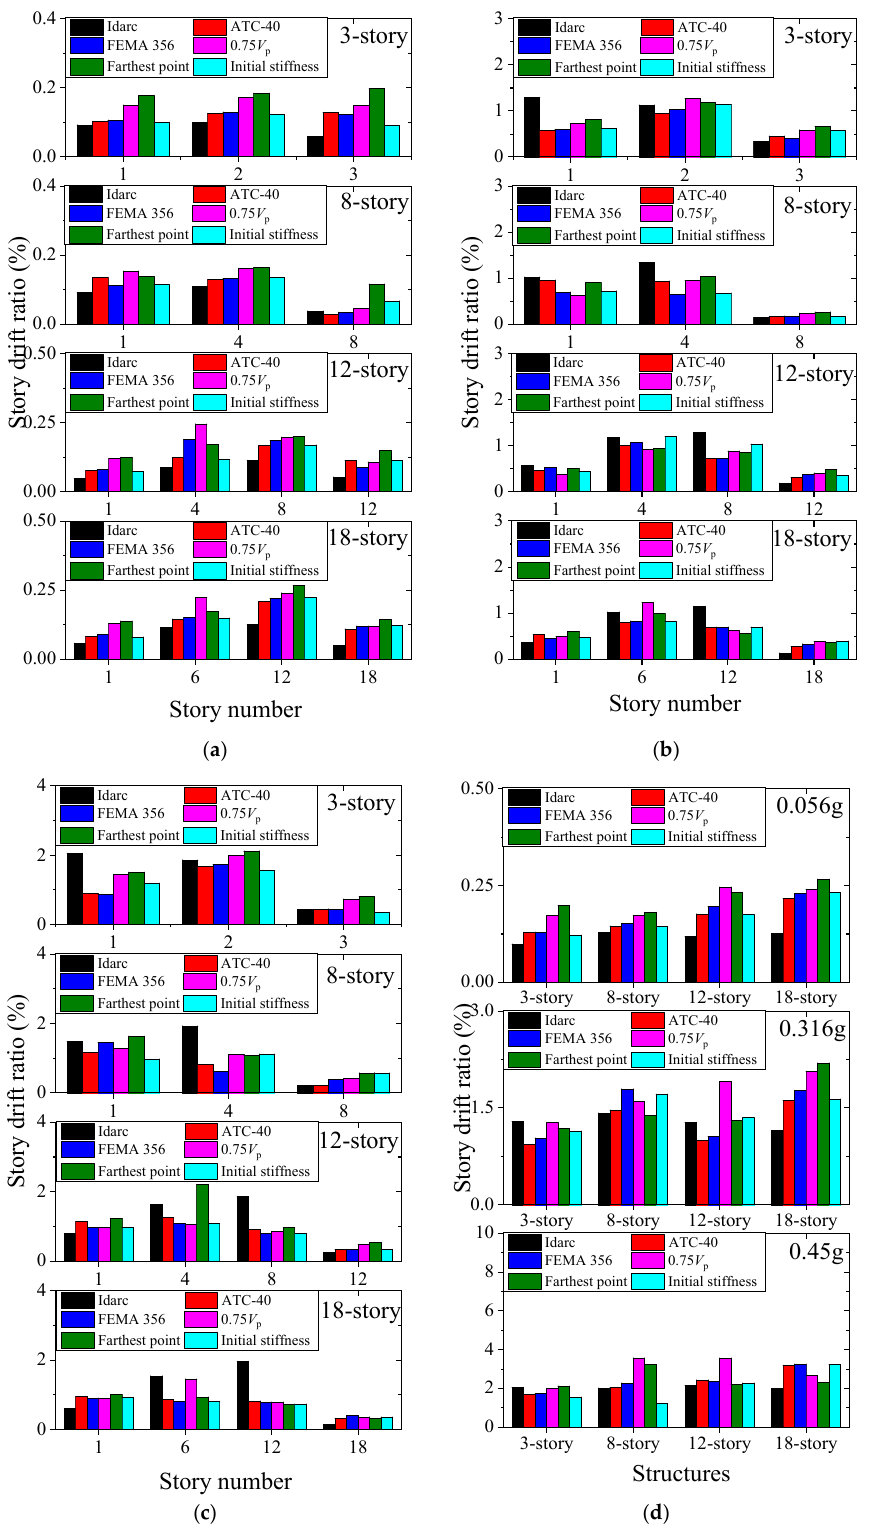
Figure 9. Story drift ratios caculated by beam-column model and five shear-building models. ( a ) PGA = 0.056 g; ( b ) PGA = 0.316 g; ( c ) PGA = 0.45 g; ( d ) PGA = 0.056 g, 0.316 g, and 0.45 g (maximum within all the stories).